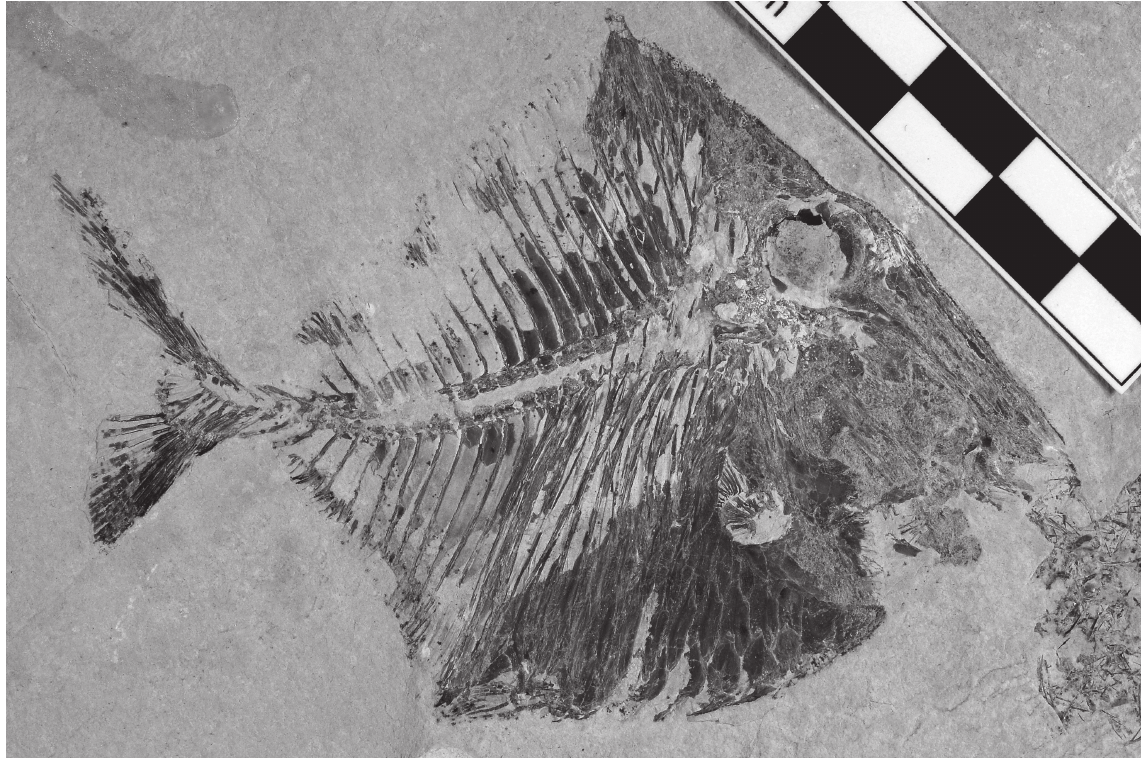
Fig. 2. Acrorhinichthys poyatoi gen. et sp. nov. Holotype